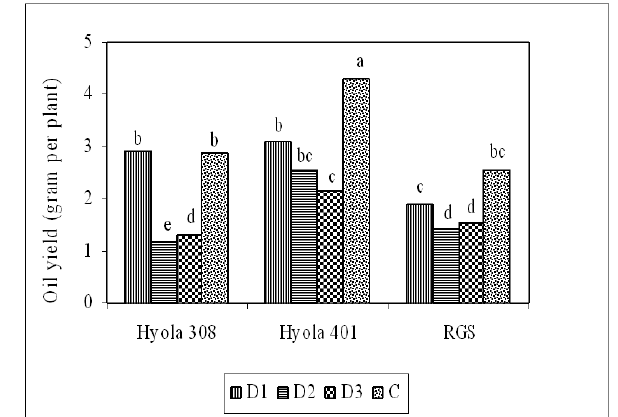
Fig. 3. Interaction of cultivars and water stress on biological yield